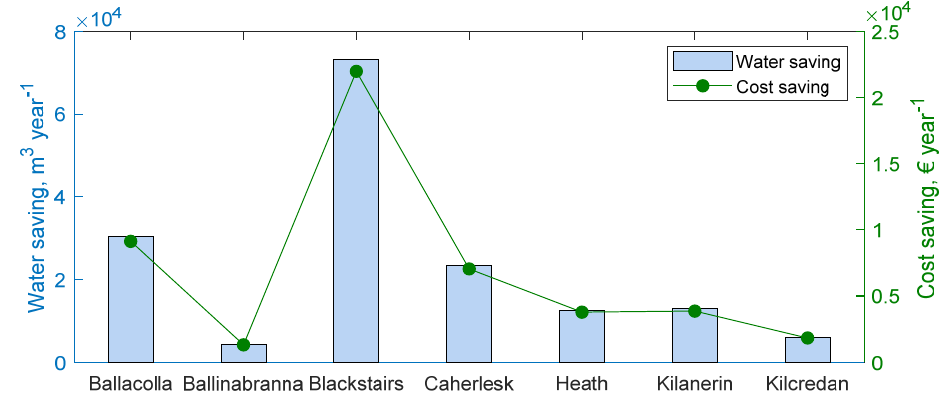
Figure 5. Water saving and water cost saving in each CORWSN in Scenario